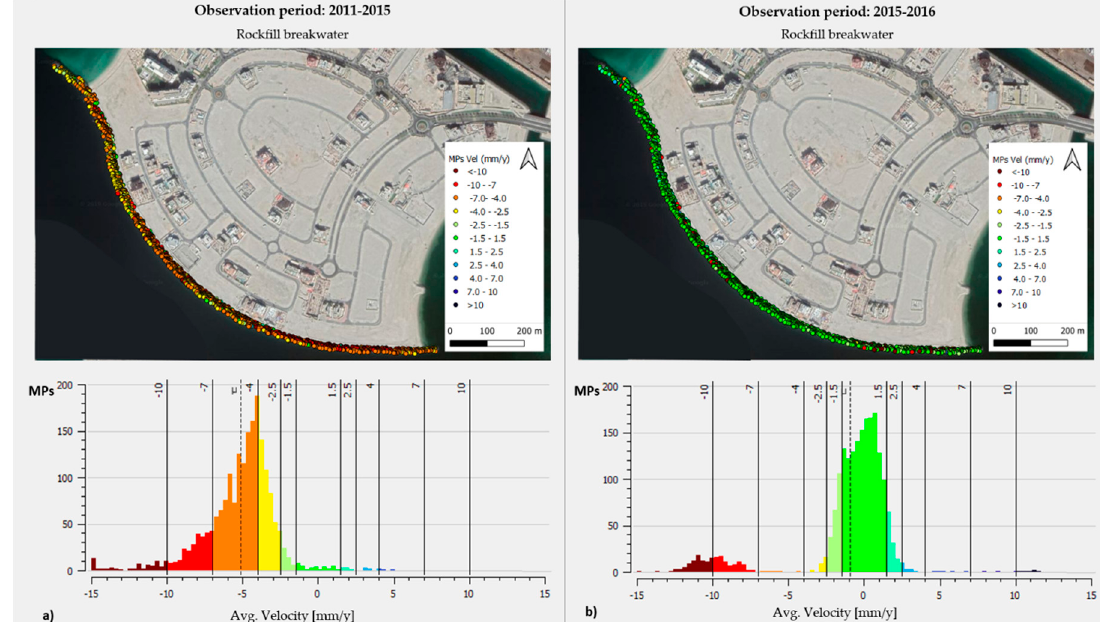
Figure 14. A-DInSAR results represented in different observation periods. ( a ) Average velocity map and histogram representing the settlements occurred over the period 2011–2015. ( b ) The average velocity map and histogram referred to the years 2015–2016 only. The color indicates the amount of displacement. Specifically, green points are considered stable (average LOS velocity between 1.5 and − 1.5 millimeters per year); while yellow to red color is referred to a movement in the opposite direction concerning the satellite sensor (i.e., in this specific case is associated to settlements). µ (dashed red line) is the average LOS velocity.